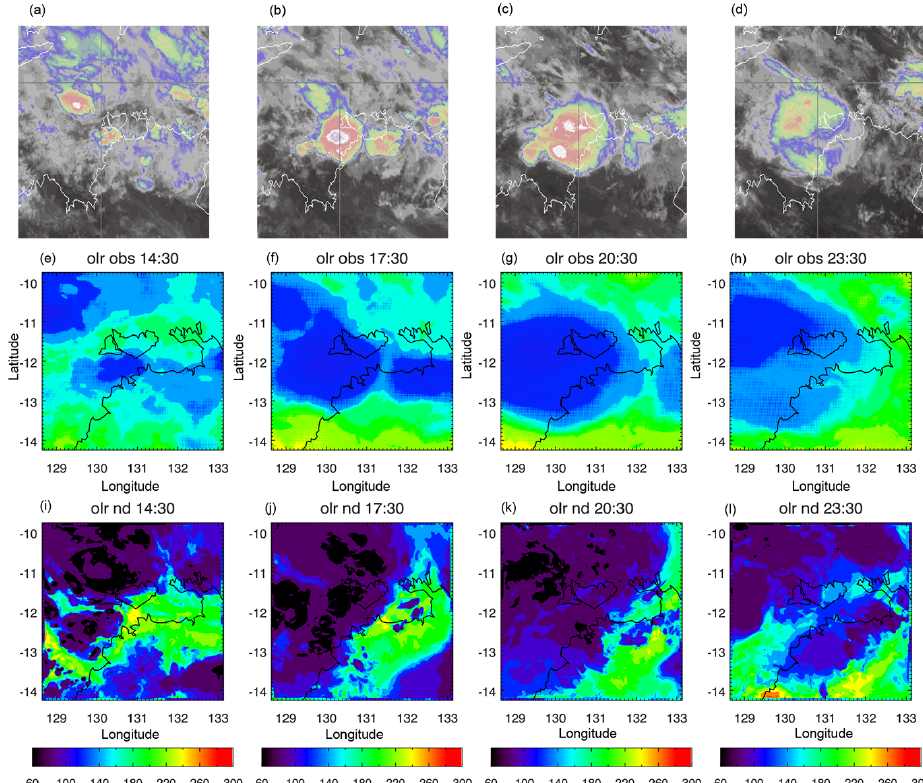
Figure 2. Top row: time series of enhanced infrared satellite imagery over the Darwin region on 18 February 2014: (a) 14:30, (b) 17:30, (c) 20:30 and (d) 23:30UTC. The temperatures range from 230K in blue through to 190K in white and purple. Middle row: time series of observed outgoing longwave radiation centred on the Darwin radar, where the pixel-level satellite data have been interpolated onto the 1km model grid. Last row: as above, but for the modelled outgoing longwave radiation from the control experiment, labelled nd.